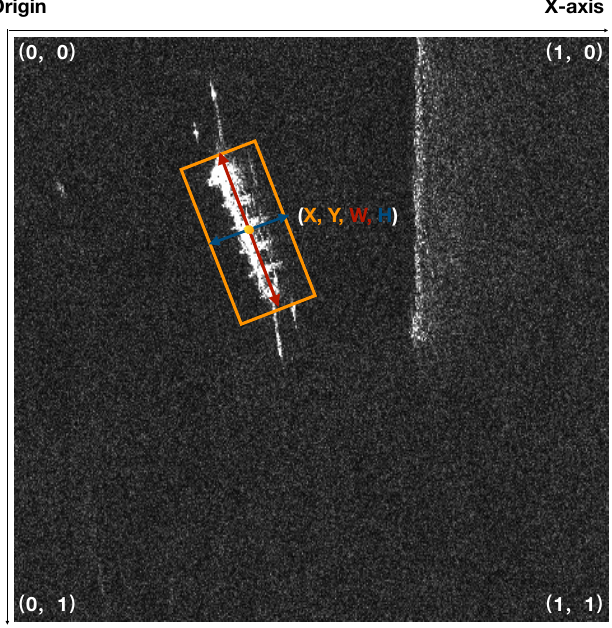
Figure 6. The annotation information of a labeled ship chip. Each ship label in the dataset is represented by a rectangular bounding box, each bounding box contains four dimensions of informa- tion, and it uses the normalized bounding box center point (x, y) and the length and width of the rectangle (w,